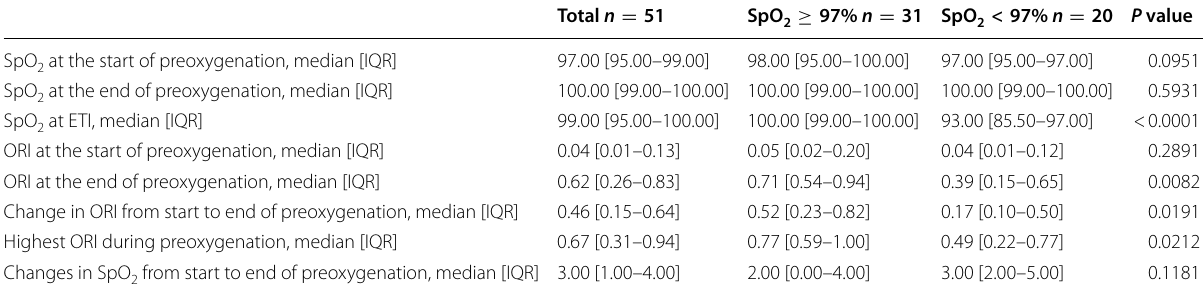
Table 2 Comparison of peripheral oxygen saturation (SpO during endotracheal intubation (ETI)